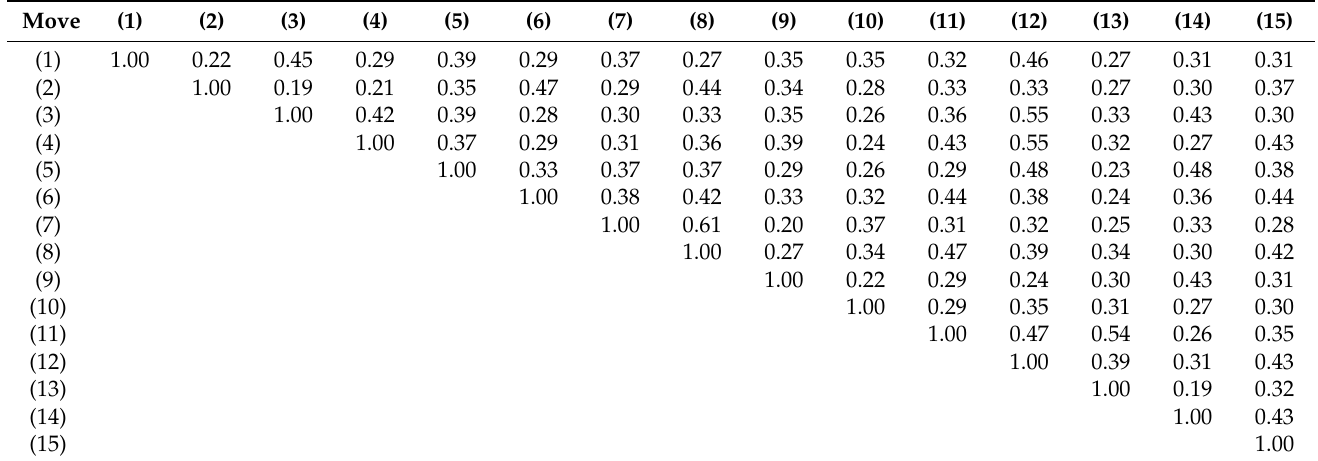
Table 1. Solo jazz template moves’ pairwise similarities calculated using the magnitudes of accel- eration and angular velocity. Depicted in red are the highest similarities obtained for each move, excluding